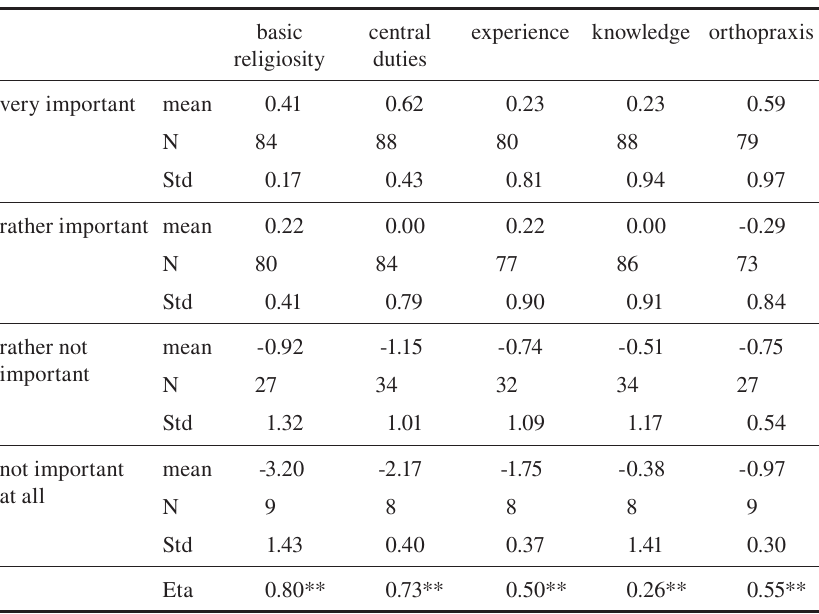
Mean differences between the five dimensions of religiosity in asso- ciation to the importance of religious rules for the everyday life